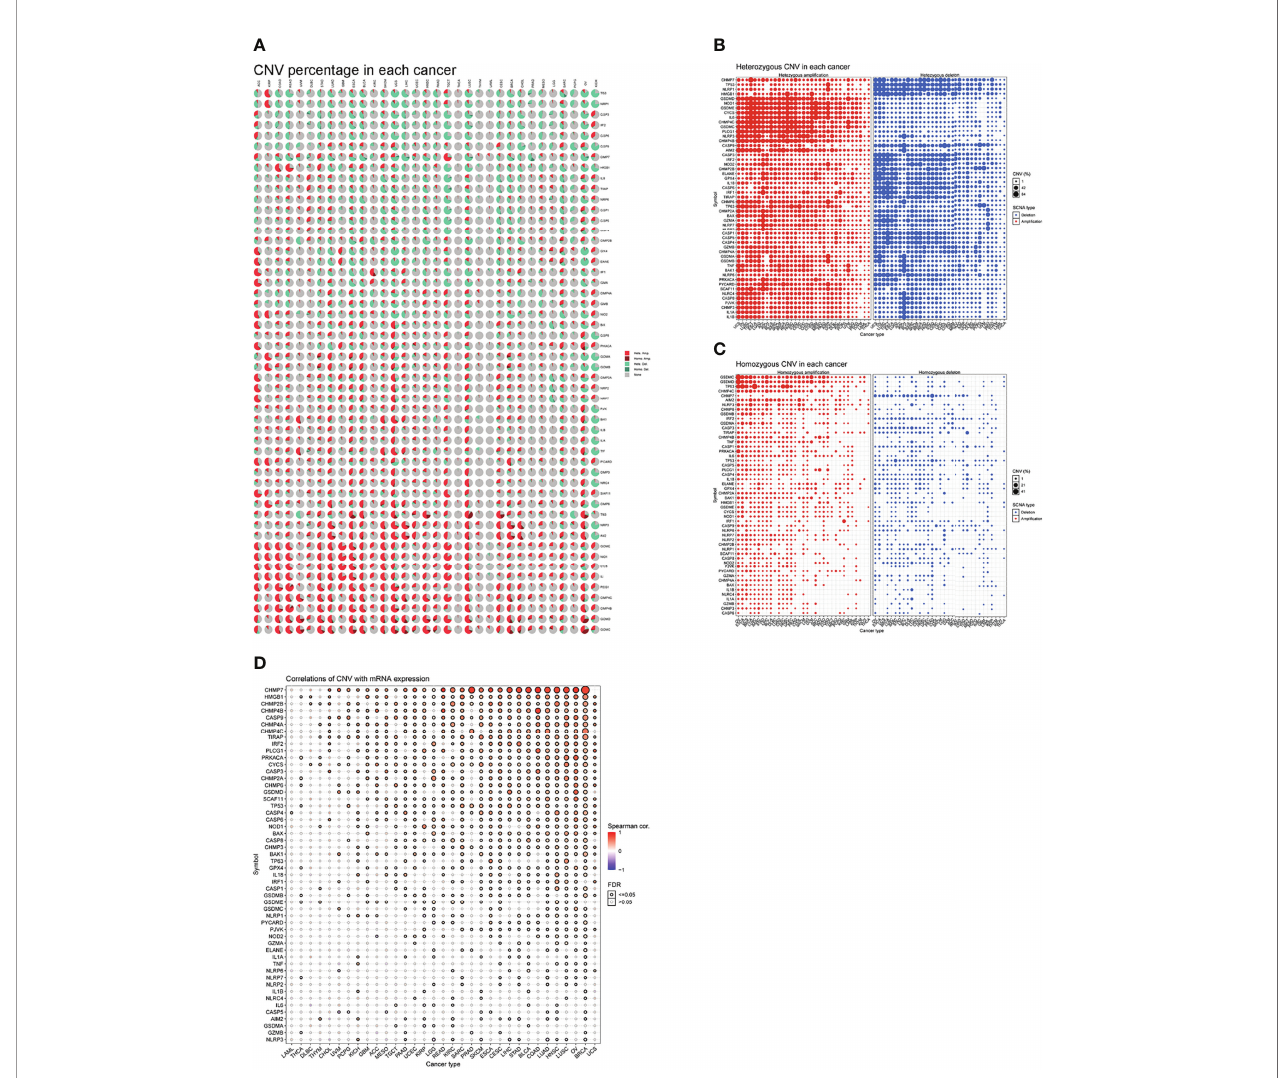
FIGURE 5 | (A) A pie chart representing the proportion of different types of CNV of one gene in one cancer, and different colors represent different types of CNV. Hete Amp = heterozygous ampli fi cation; Hete Del = heterozygous deletion; Homo Amp = homozygous ampli fi cation; Homo Del = homozygous deletion; None = no CNV. (B) Heterozygous CNV pro fi le, including ampli fi cation and deletion percentage for each gene in each cancer. Only genes with >5% CNV in cancers are shown. The size of the point represents the statistical signi fi cance, where the bigger the dot size, the higher the statistical signi fi cance. FDR, false discovery rate. (C) Homozygous CNV pro fi le, including ampli fi cation and deletion percentage for each gene in each cancer. Only genes with >5% CNV in cancers are shown. The size of the point represents the statistical signi fi cance, where the bigger the dot size, the higher the statistical signi fi cance. FDR, false discovery rate. (D) mRNA expression and CNV data merged by TCGA barcode. The association between paired mRNA expression and CNV percent samples was tested based on Pearson ’ s product-moment correlation coef fi cient and follows a t -distribution. The size of the point represents the statistical signi fi cance, where the bigger the dot size, the higher the statistical signi fi cance. FDR, false discovery